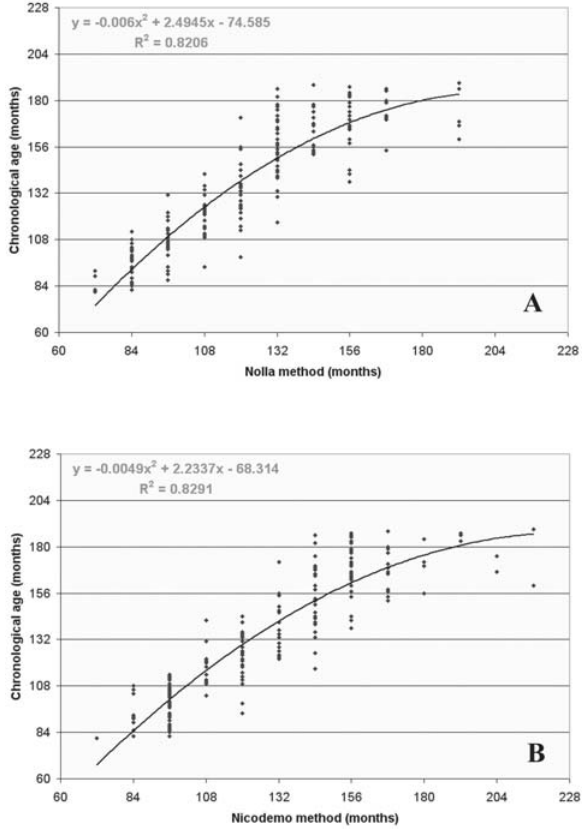
FIGURE 3- Scatter plots and straight line and curves adjusted for regression equations between estimated dental age (X) and chronological age (Y) obtained by both methods for Brazilian girls. A: Nolla method; B: Nicodemo’s, et al.